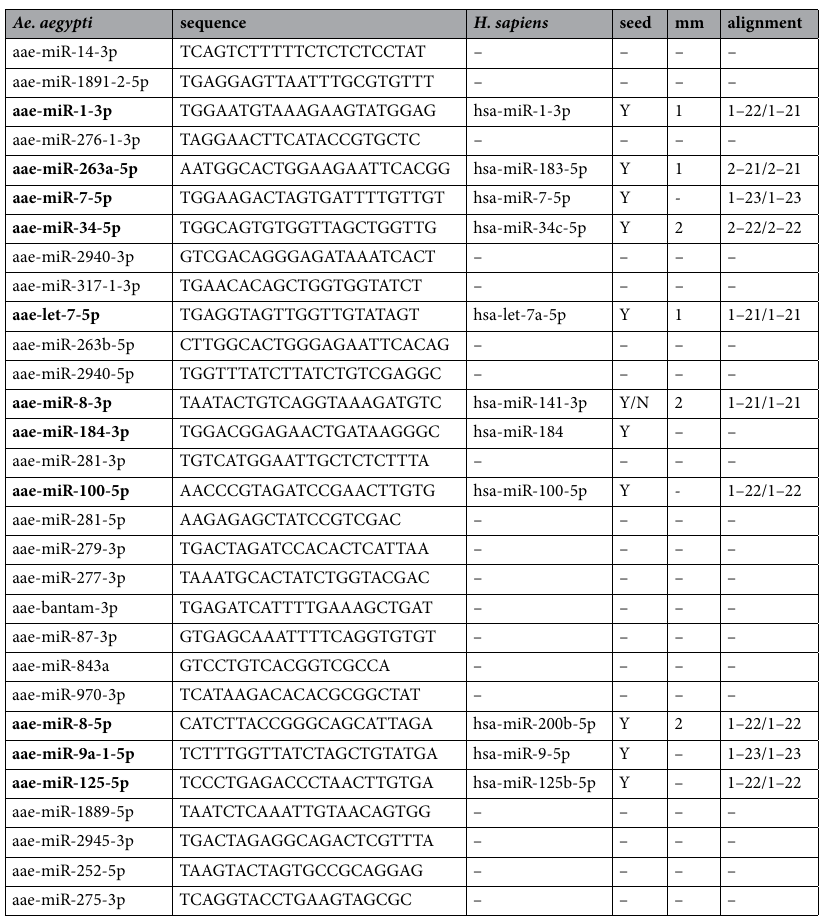
Table 2. Human orthologues among the 30 most abundant saliva miRNAs from uninfected Ae. aegypti . Y, seed (nt 2–8) fully conserved; Y/N, seed partially conserved; mm, total number of mismatches in the aligned region. Aedes aegypti miRNAs with human orthologues are in